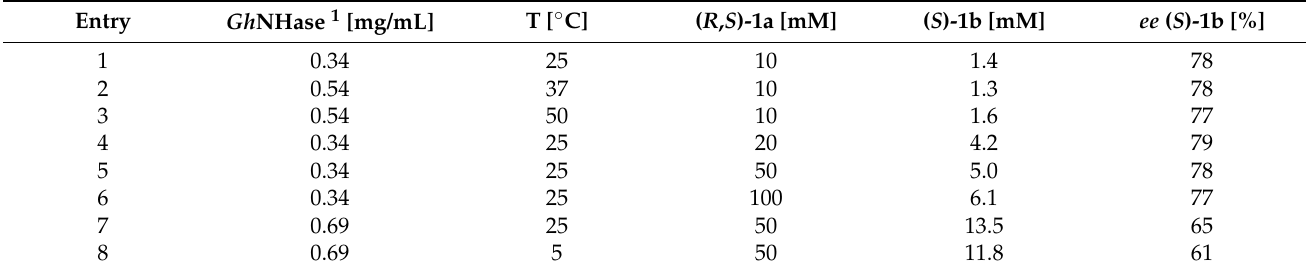
Table 1. Effects of reaction temperature, amount of racemic substrate ( R , S )- 1a and amount of Gh NHase on product titer and enantiomeric excess. Data selected from iterative reaction engineering